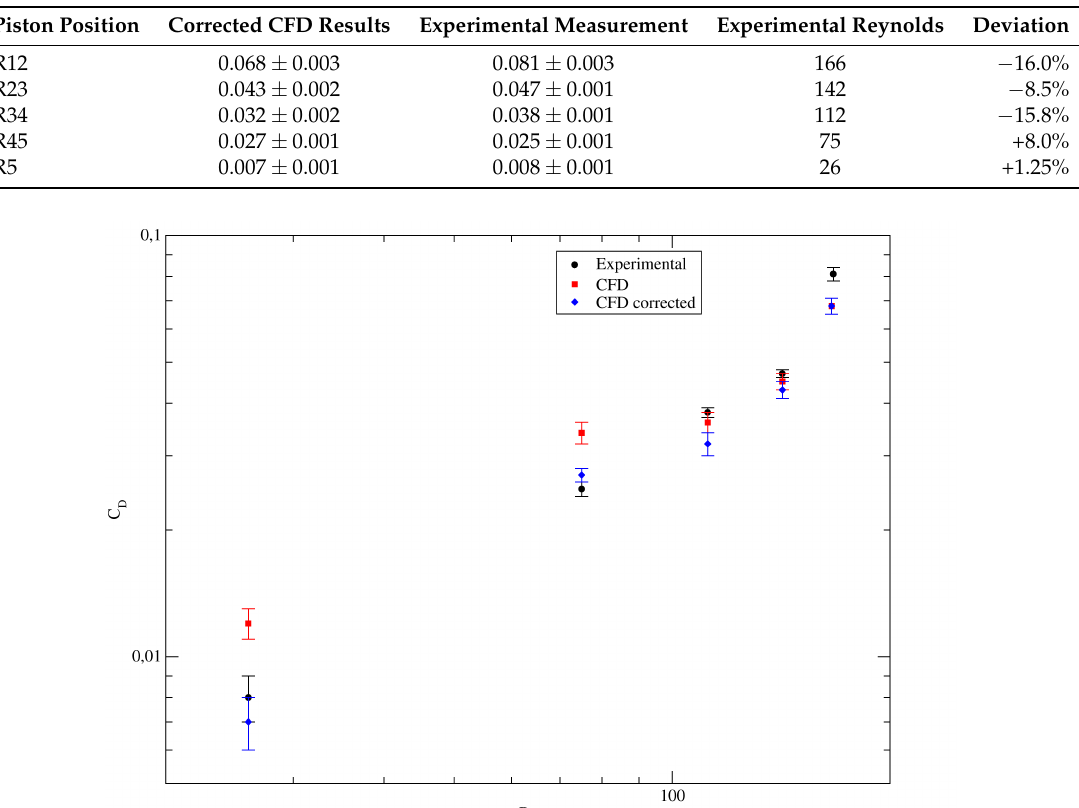
Figure 12. Flow-rate coefficients versus Reynolds number for experimental measurements, CFD computations and corrected CFD results, using correlation Equation